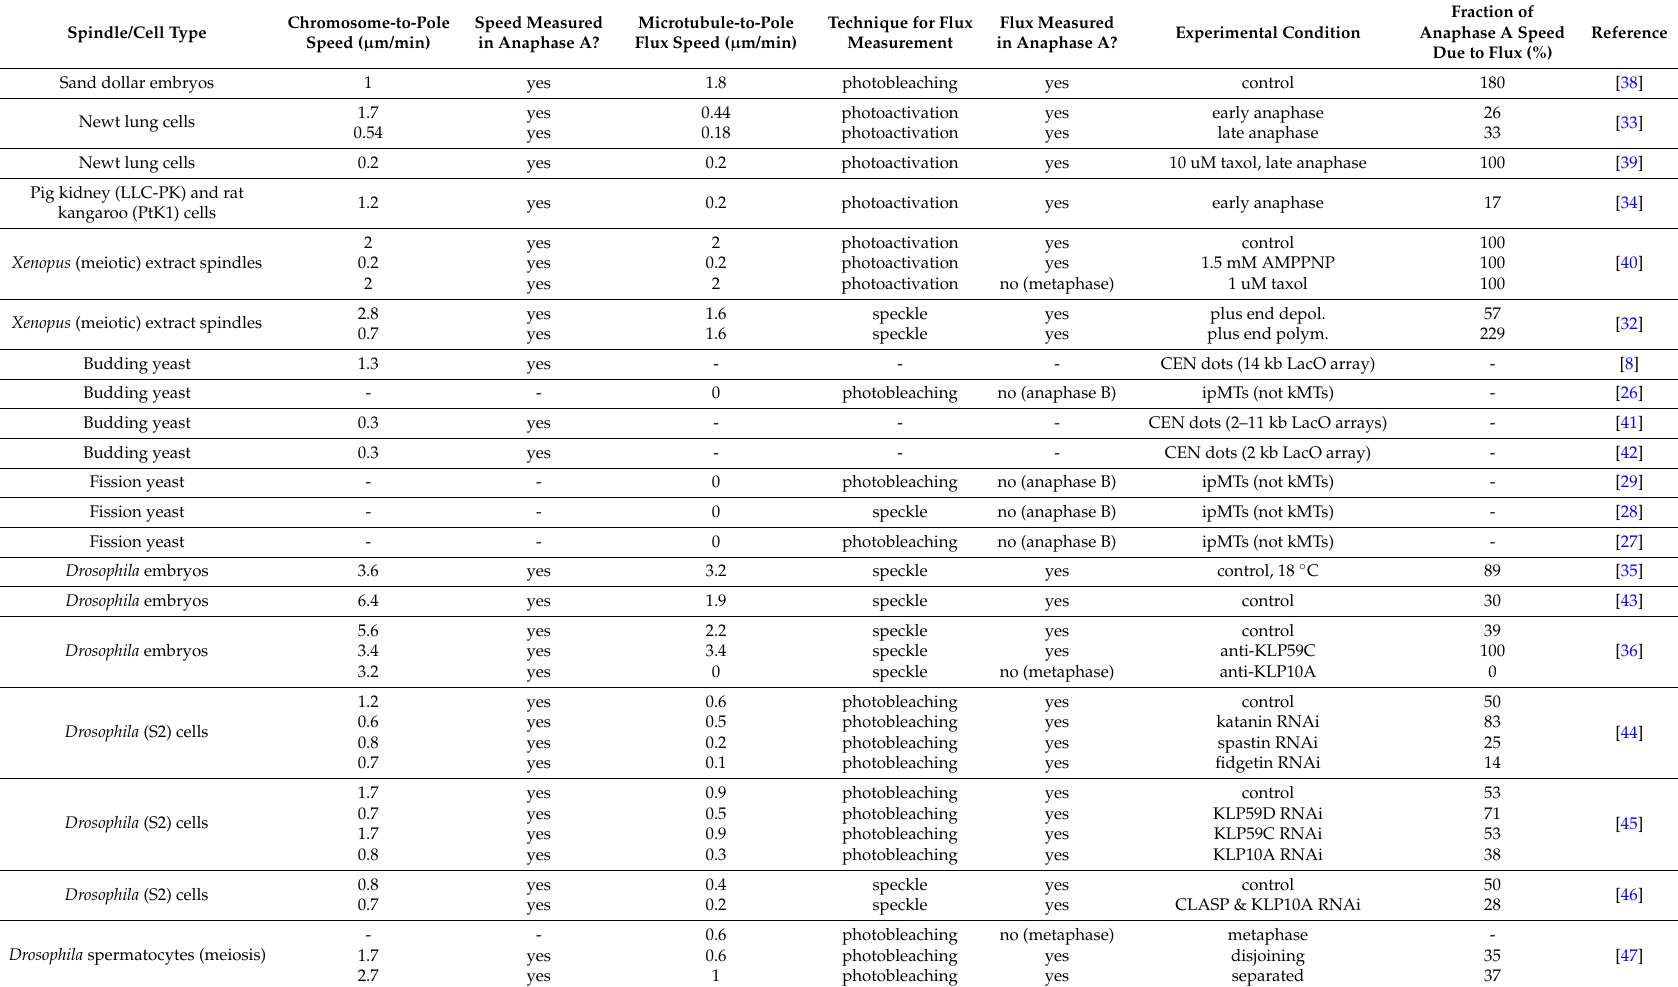
Table 1. Speeds of chromosome-to-pole anaphase A motion, and microtubule-to-pole flux motion, measured in various spindle/cell